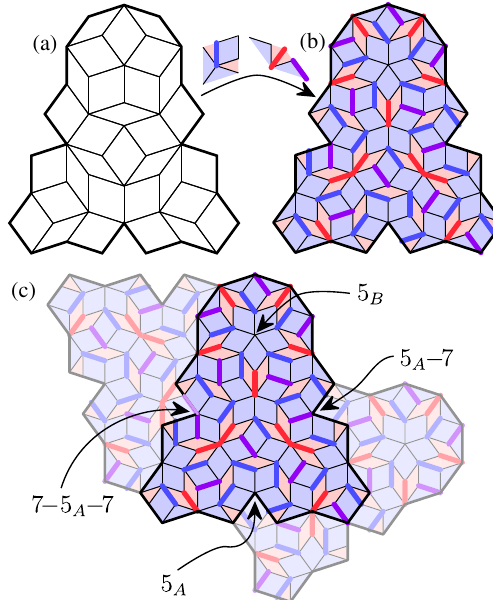
FIG. 10. Proof that the dimer inflation algorithm of Sec. IVA associates monomers with 5 -vertices based on how many 7- A;B vertices they have as second-nearest neighbors [points (i) – (iii) in that section]. (a) The local empire of the 4-vertex is large enough to cover the Penrose tiling, allowing for overlaps. (b) Inflating FIG. 11. The local empire of the 6-vertex with key vertices using the dimer-decorated inflation rules leads to a set of tiles identified, used in the proof in Sec. IV B and Appendix B that the large enough to cover the inflated tiling. (c) To confirm state- dimer inflation algorithm in Fig. 8(b) generates maximum ments (i) – (iii) about monomer placement, it is necessary to check matchings. Solid (dashed) circles indicate vertices of definite every continuation of the boundary vertices. Two continuations (potential) valence: red 7-vertices, blue 5 are shown, with relevant features highlighted: a 5 vertices. Solid (dashed) thick black lines indicate definite -vertex, and B 5 (potential) segments of monomer membranes (which cannot be -vertices with zero, one, and two 7-vertices as second-nearest A covered by dimers or crossed by neighbors.